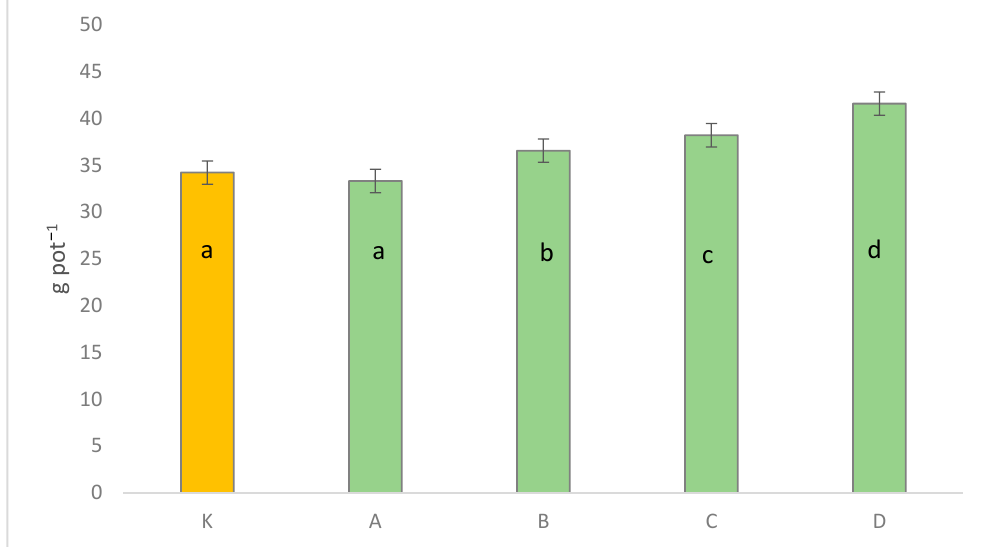
Figure 1. Yield of soybean seeds depending on stress regime (n = 96); ± LSD ( p ≤ 0.05); different lower case means significant differences in the Tukey test; K—control object; A—short stress after sowing; B—short stress after 3 days after sowing; C—short stress after 6 days after sowing; D—long stress after sowing.